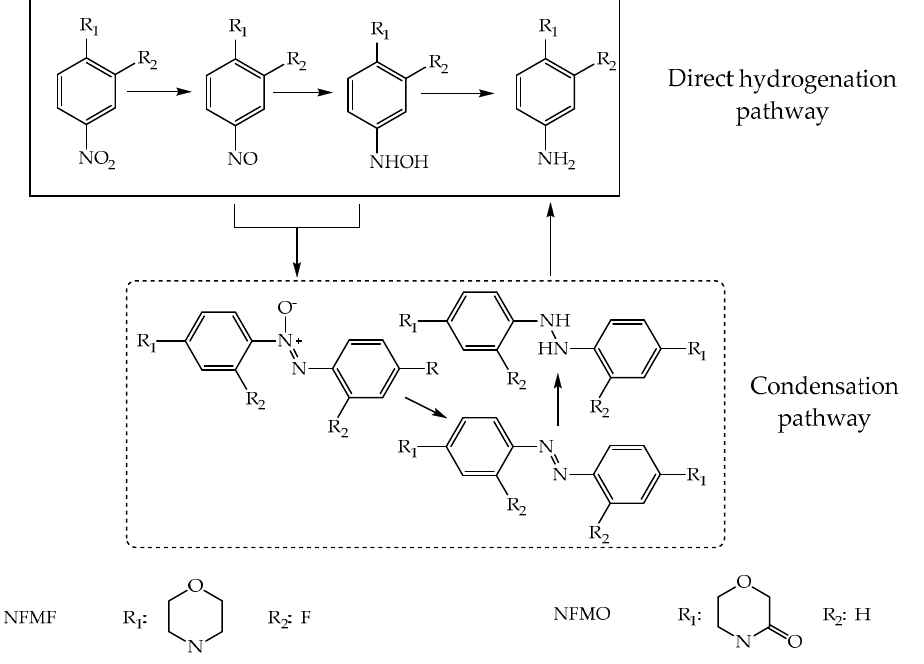
Figure 6. Conversion curves as a function of time for hydrogenation of the substrates of pharmaceutical interest on the catalysts (x)Au/ANW. ■— 0.25Au/ANW; ▲— 0.50Au/ANW and ● — 1.00Au/ANW. Straight lines correspond to the kinetic pseudo-first order adjustment.